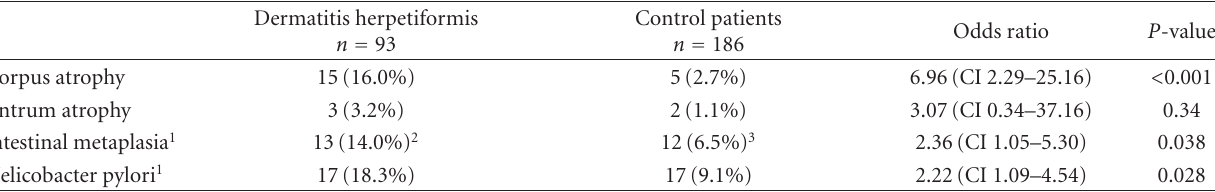
Table 1: Gastric findings in the 93 patients with dermatitis herpetiformis (female 40, median age 48 years; range 7–76) and 186 control patients with dyspepsia (female 80, median age 56 years; range